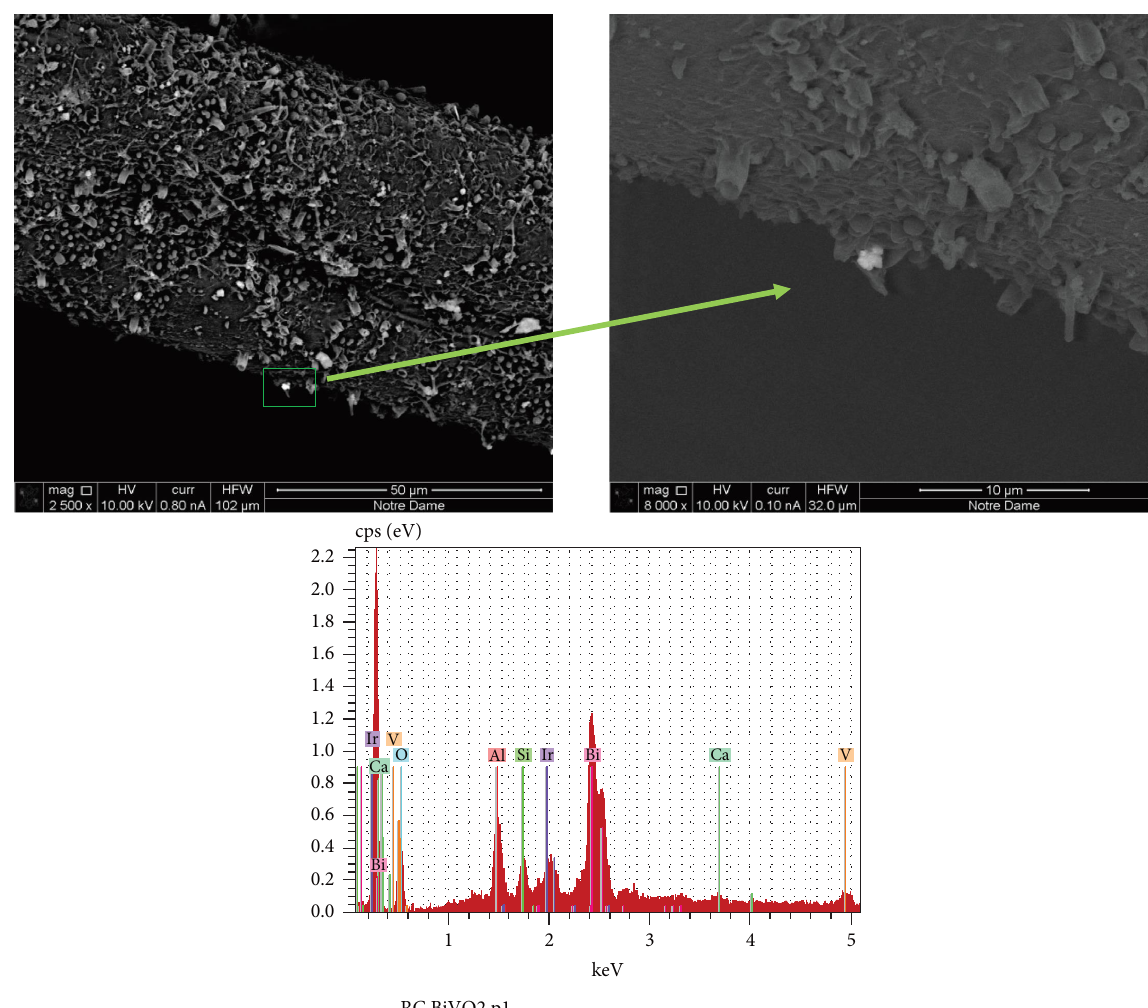
Figure 5: SEM/EDX image of cattail root showing the presence of BiVO